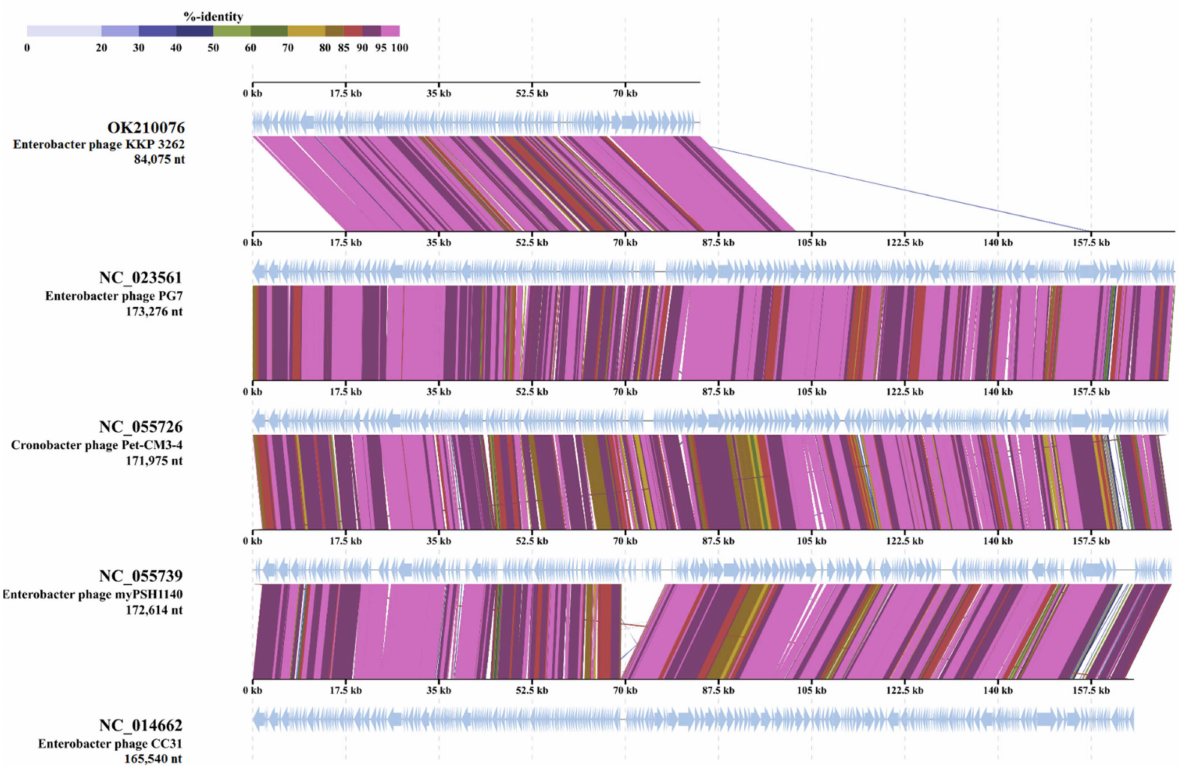
Figure 11. Genome sequence comparison of the Enterobacter phage KKP 3262 with four other Myoviridae -related phage genomes exhibiting co-linearity detected by TBLASTX using ViPTree server [84]. Homologous regions detected by a TBLASTX search are connected by segments colored based on amino acid identity. The color bar shows the % identity of TBLASTX.